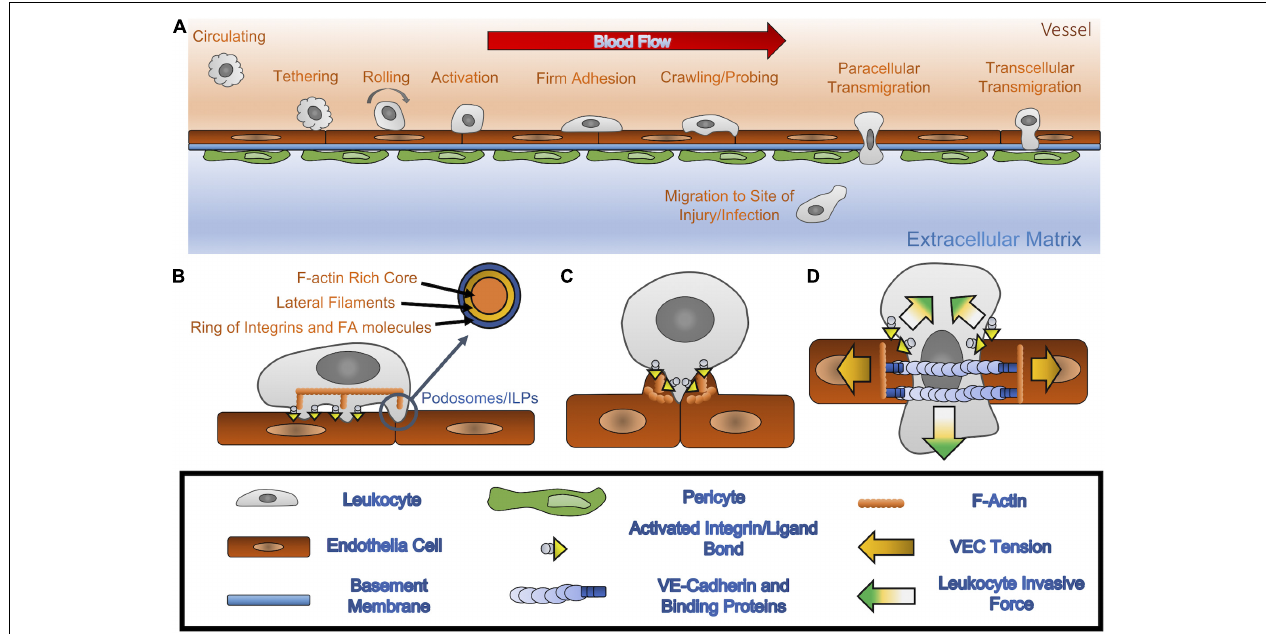
FIGURE 1 | (A) Leukocyte extravasation: through the presence of inflamed VECs, circulating leukocytes localize themselves in the proximity of affected tissues. Once in range, leukocytes use carbohydrate ligands to tether themselves to VECs that express specific selectins. Once tethered, the leukocyte is then able to roll along the endothelium by creating and breaking bonds between the selectins and carbohydrate ligands. Upon the activation of integrins into a high affinity state, triggered by chemokines binding to leukocyte’s chemokine receptors, the leukocyte can transition into a firm adhesion state that stops the rolling and allows the leukocyte to spread out. The leukocyte then crawls and probes the vessel wall in search of VEC hotspots through which it is then able to transmigrate. This maneuver allows for leukocytes to breach the endothelium and basement membrane, thus permitting them to reach the affected tissue area. (B) Crawling/probing: leukocyte-VEC interactions, through high affinity integrins coupled with their respective CAMs, allow the leukocyte to migrate laterally, with the CAMs dictating the migration pattern of the leukocyte along the vascular wall. Furthermore, the leukocyte can convert focal adhesions to invadosome/podosomes like protrusive (ILP) structures, which are sensory organelles that they then utilize to search for TEM hotspots. (C) The transmigratory docking structure: once a hotspot is identified, a cluster of ICAM-1 creates a cup formation to hold on to the transmigrating leukocyte. This docking structure allows the leukocyte to transition from lateral migration to TEM. (D) TEM (paracellular): once in position at the sides of the VEC junction, leukocytes can increase VEC contractility, disrupting the local monolayer tension and creating strong downward pushing forces, which allow for a junctional gap to form and increase in size, and for invasion of the basement membrane. This widened gap allows for the leucocyte to push through the junction and break cellular bonds between